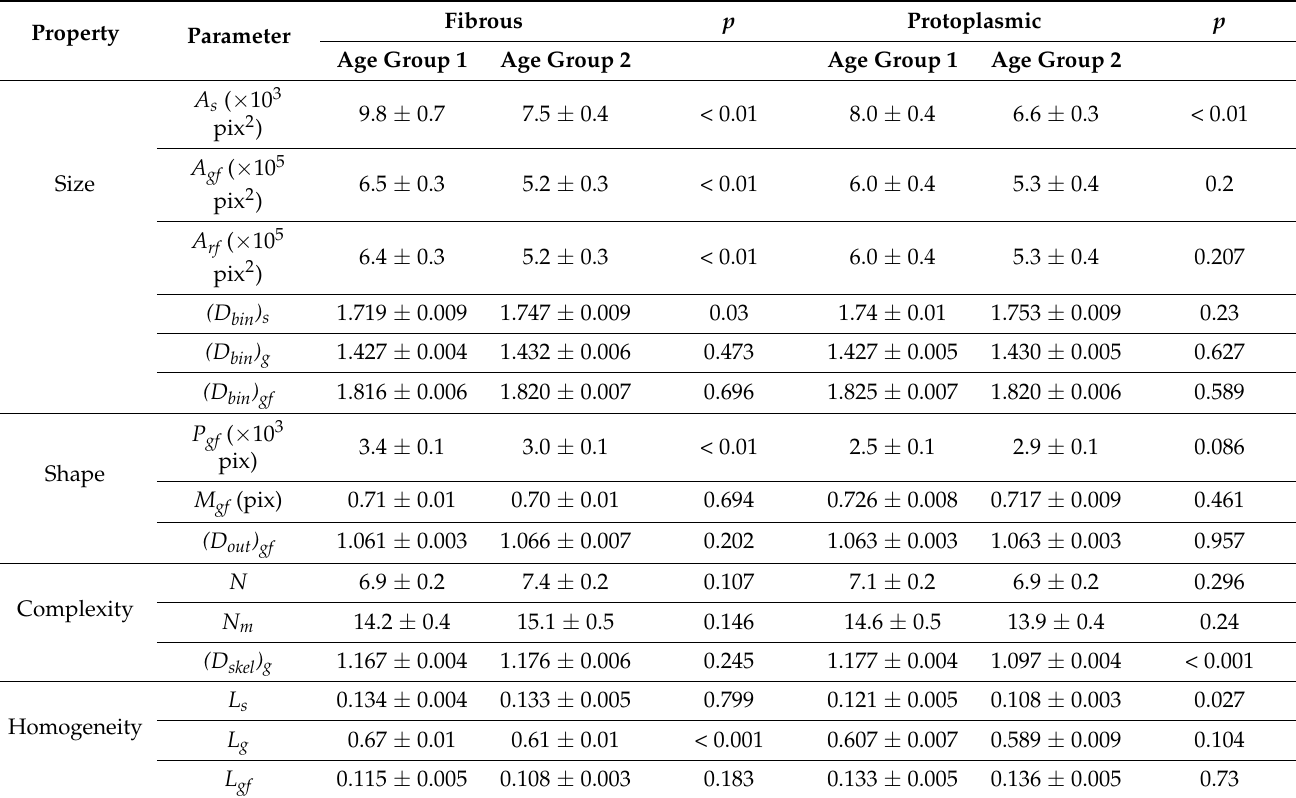
Table 4. The mean values (standard errors) between second groups of maturation (Age Group 1) and aging (Age Group 2) in fibrous and protoplasmic astrocytes. Column p shows a statistical estimate of the differences between the